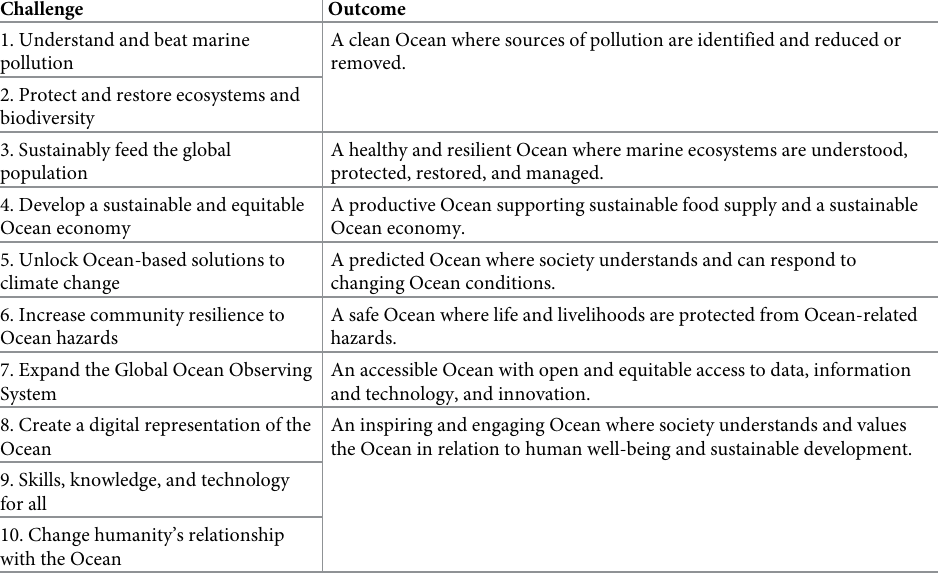
Table 1. The UN Decade of Ocean Science for Sustainable Development 10 challenges for collective impact and 7 societal